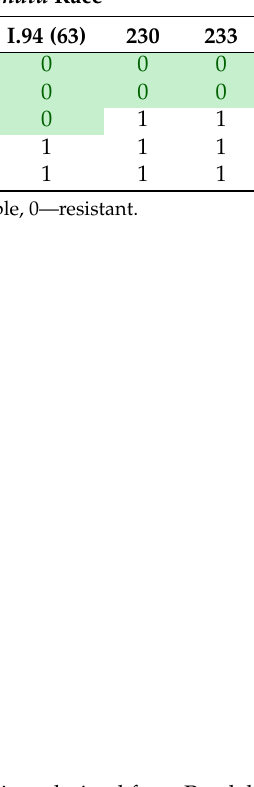
Figure 1. UPGMA dendrogram of oat isolines derived from Pendek × CW 486-l crossing based on the similarity of infection obtained by 14 P. coronata races inoculation.